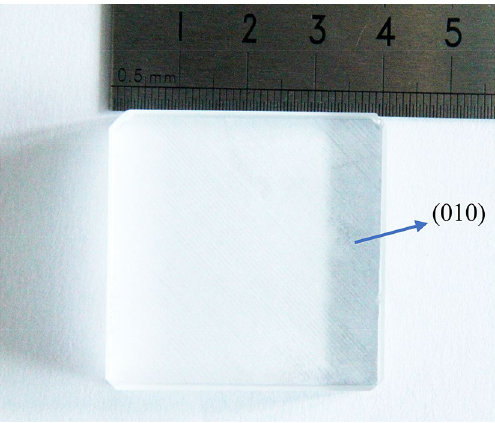
Figure 13. The bulk single-crystal KDP with a dimension of 40 mm × 40 mm × 10 mm.